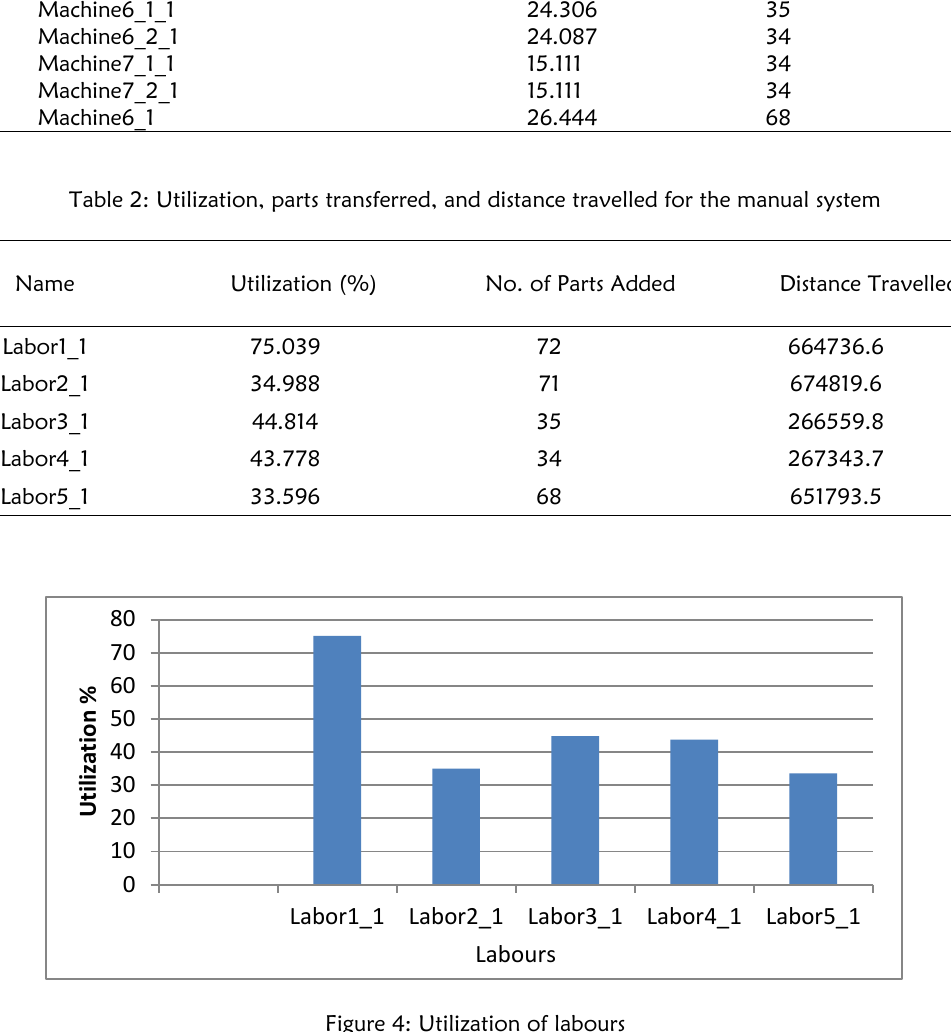
Figure 4: Utilization of